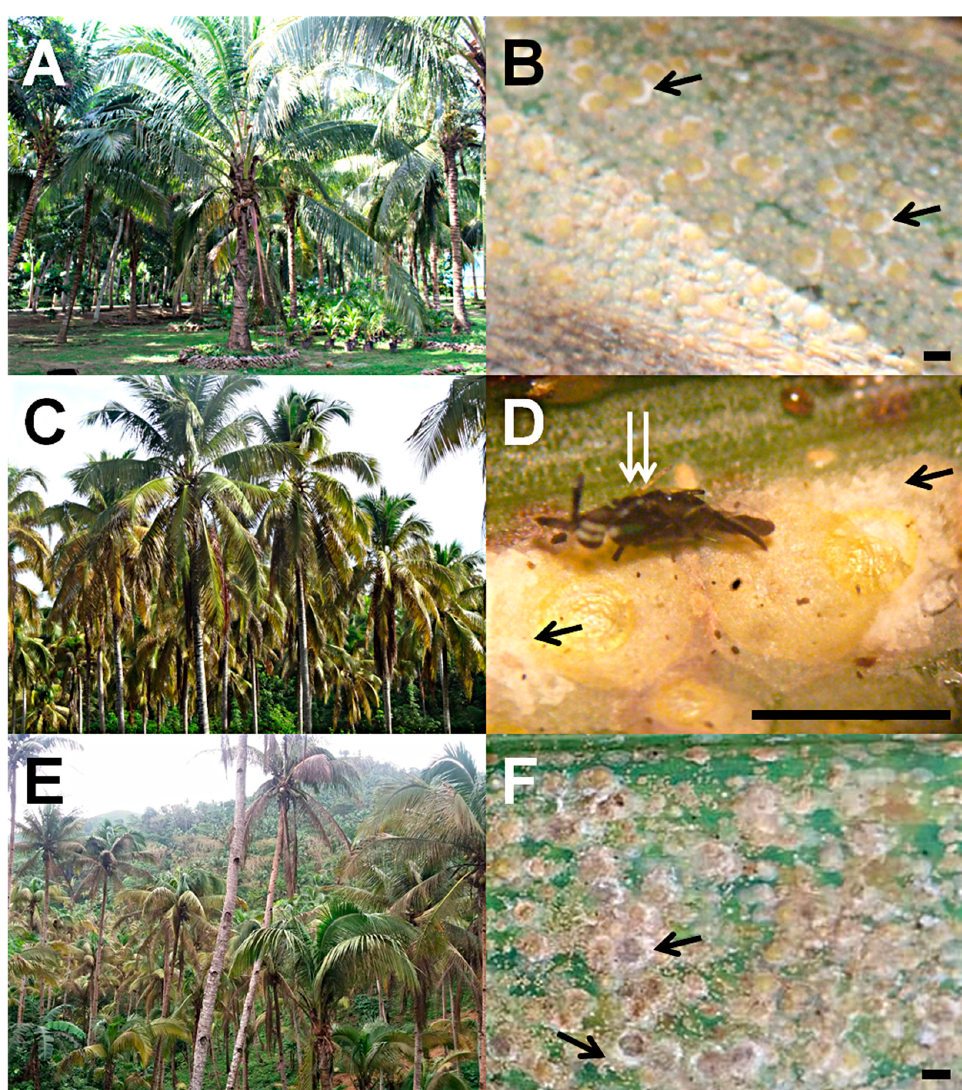
Figure 4. Aspidiotus rigidus -infested coconut trees with magnified view of scale colony samples from: Zamboanga City ( A , B ); Isabela City, Basilan ( C , D ); and Tablas Island, Romblon ( E , F ). Black arrows point to the characteristic distribution of eggs and egg skins along the pygidial ends of mature female A. rigidus which can be used as basis to quickly distinguish this species from other Aspidiotus spp. on coconut. White double arrow points to female Comperiella calauanica . Scale bars on the photomicrographs approximate 1.0 mm.